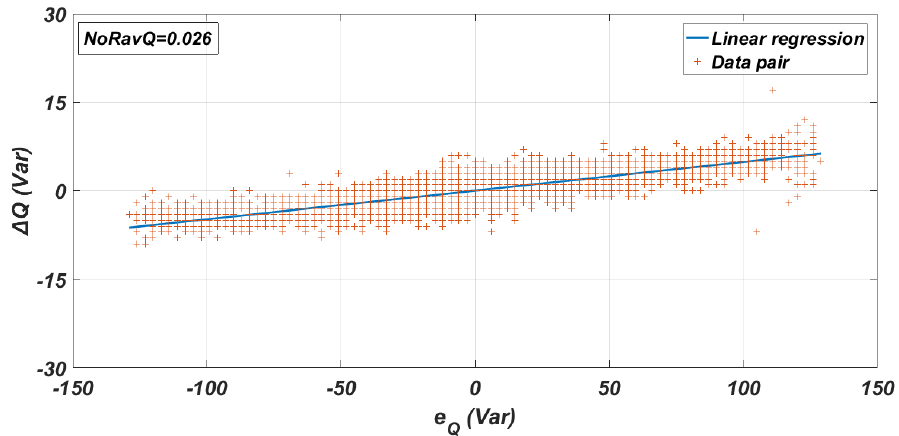
Figure 6. Plot and linear regression of [ e Q ( t ), ΔQ ( t )] pairs used for the calculation of NoRavQ for the properly configured PTMVR control method.